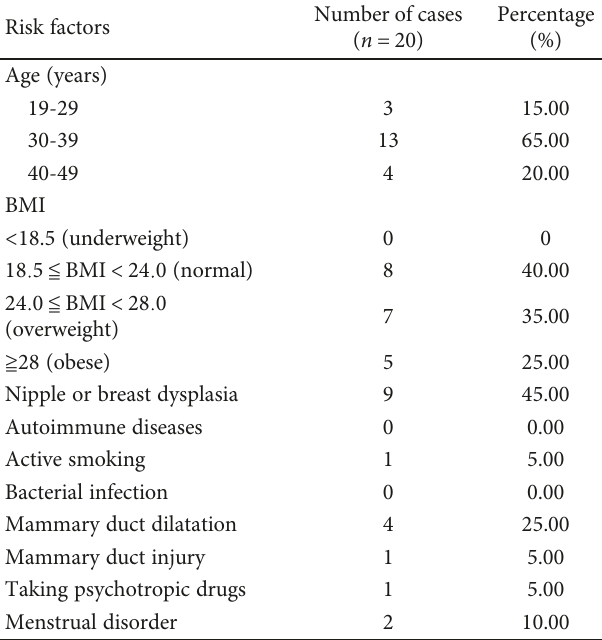
Table 1: Risk factor analysis of